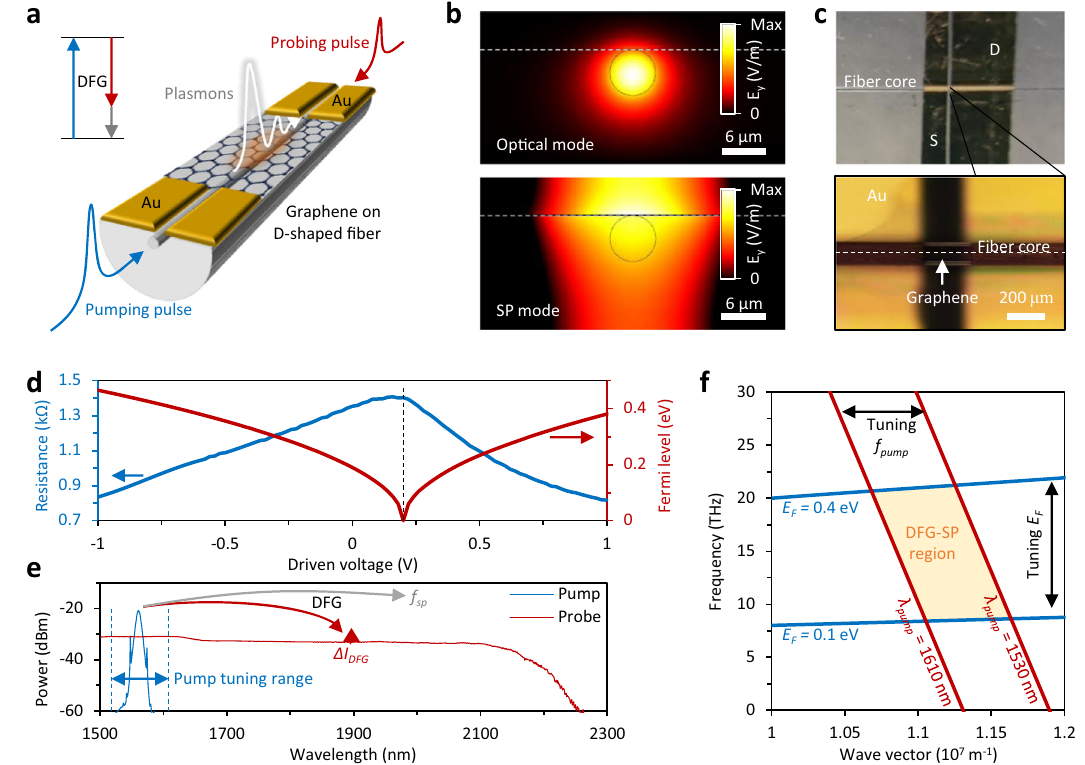
Fig. 1 Generation and control of graphene ’ s plasmons in a graphene heterogeneous fi bre device. a Schematic of the graphene optoelectronic device deposited on a D-shaped fi bre. DFG via the surface χ (2) nonlinearity is excited by two counter-propagating synchronized pulses. DFG difference-frequency generation. Inset: energy conservation for the DFG process. b Simulated electrical fi eld distributions of an optical mode propagating in the fi bre core and a plasmonic mode propagating along the graphene- fi bre interface (transverse magnetic polarization, E y ). SP surface plasmon. Scale bar: 6 μ m. The horizontal dashed line shows the fi bre-air interface. Colour bar: normalized E y . c Top-view microscope image of the graphene transistor on- fi bre. The white dashed line shows the fi bre core, the monolayer graphene is connected by two Au electrodes, with contact channel length 200 μ m. d Measured resistance and calculated Fermi level, the sampling rate is 20 mV. e Spectra of the pump comb (blue) and the probe comb (red). The red and grey arrows illustrate the DFG process. f sp the frequency of surface plasmon, Δ I DFG the DFG enhanced signal intensity. f Parametric space of the DFG plasmons. The blue curves show the electrically tunable dispersion of graphene, while the red curves show the optically tunable phase-matching condition. f pump the frequency of pump, E F the graphene ’ s Fermi level, the shaded area demonstrates the possible region of the graphene nonlinear generation in our